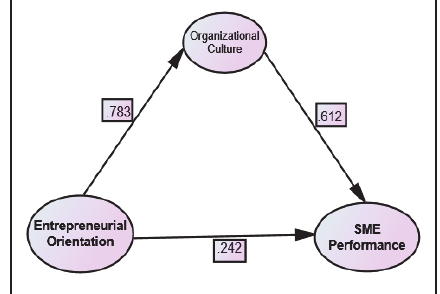
Fig. 4. Standardized Regression Weights for the Model Bootstrapping: Results of Mediation for Confirmation